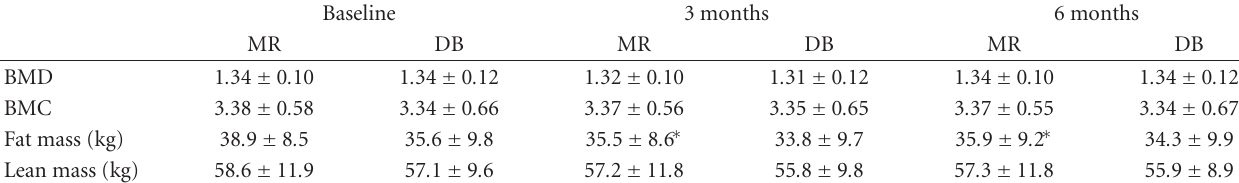
Table 4: Bone density, bone mineral content, fat and lean mass, by dual X-ray absorptiometry at baseline 3 and 6 months in subjects who completed the study.